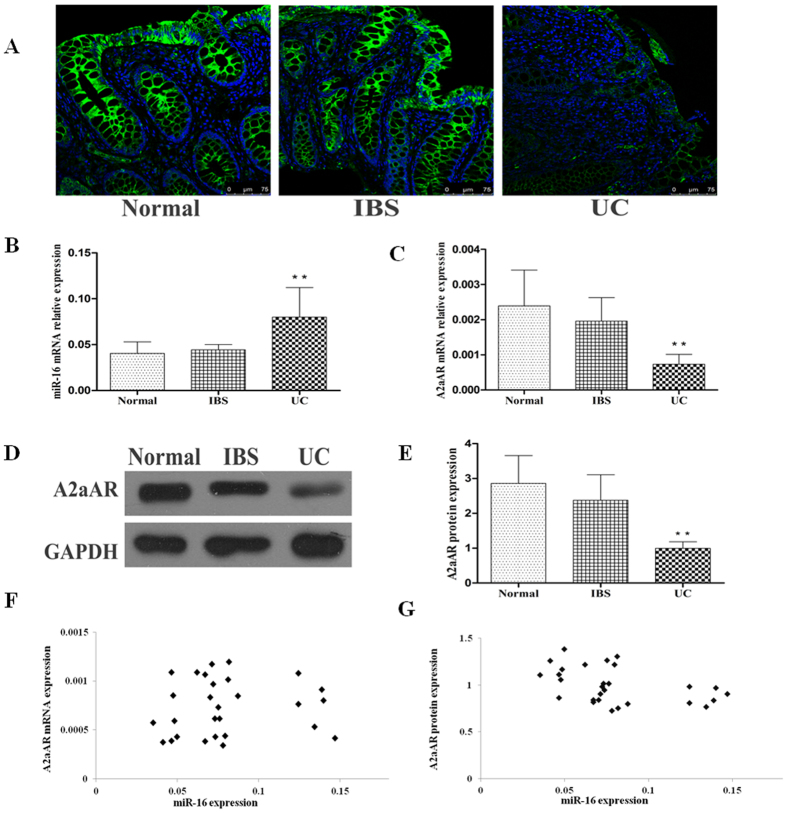
Expression of the A2aAR and miR-16 in tissues.(A) IF staining of sigmoid biopsy section using specific antibody to label A2aAR protein and DAPI for counterstaining the nuclei (Blue). The strong green fluorescence signal indicating A2aAR was observed mainly in the sigmoid colonic epithelial cells. The expression of A2aAR was reduced in UC inflamed tissues. (B) miR-16 expression, and (C) A2aAR mRNA expression in individual sigmoid colon tissues (normal controls n = 20, IBS n = 22 and active UC n = 28), were measured by qRT-PCR (Data are shown as mean ± SD, **P < 0.01). (D) A representative image of western blot for detecting A2aAR protein expression in sigmoid colon tissues. (E) A2aAR protein expression in sigmoid colon tissues was based on the ratio of band density of A2aAR to GAPDH protein. The band density of a western blot was measured using Quantity One software. (normal controls n = 20, IBS n = 22 and active UC n = 28. Data represent mean ± SD, **P < 0.01). (F) Correlation between miR-16 and A2aAR mRNA expression in active UC inflamed sigmoid tissues (n = 28, Pearson correlation r = 0.095, P > 0.05). (G) Correlation between miR-16 and A2aAR protein expression, miR-16 expression showed a strong negative correlation with A2aAR protein level in active UC inflamed sigmoid tissues (n = 28, Pearson correlation r = −0.438, P < 0.05).